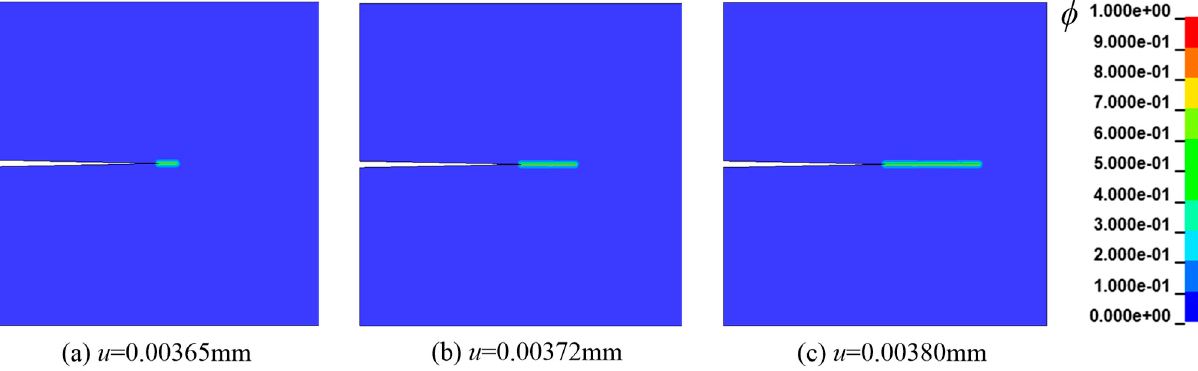
Figure 7. Crack growth process in Case 1( C 0 = 0.5 wt ppm).